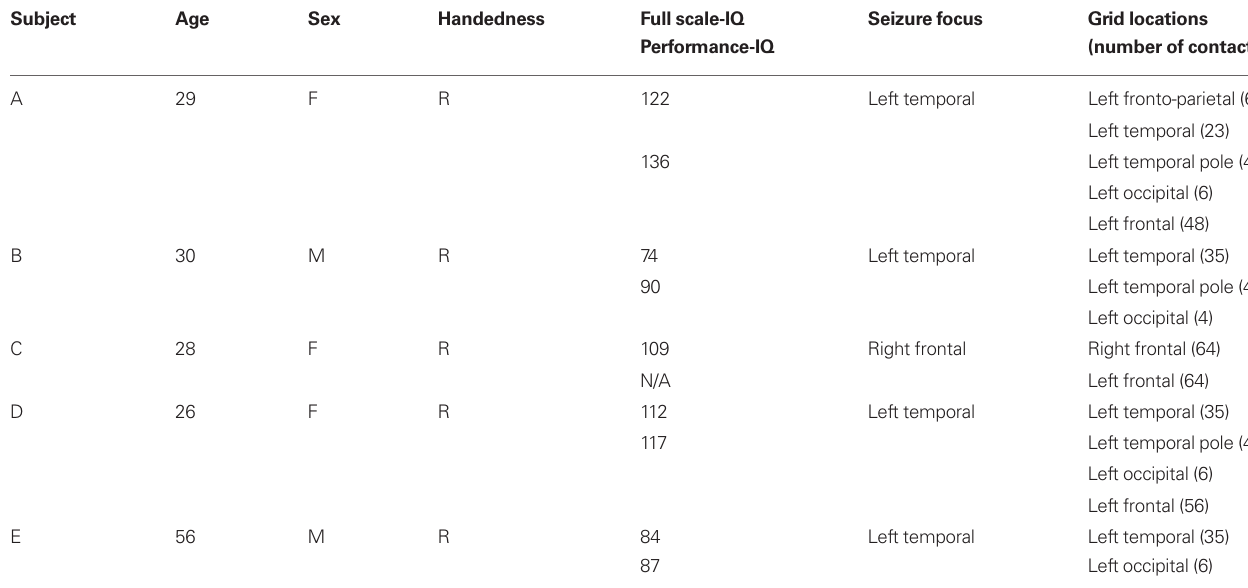
Table 1 | Clinical profiles of